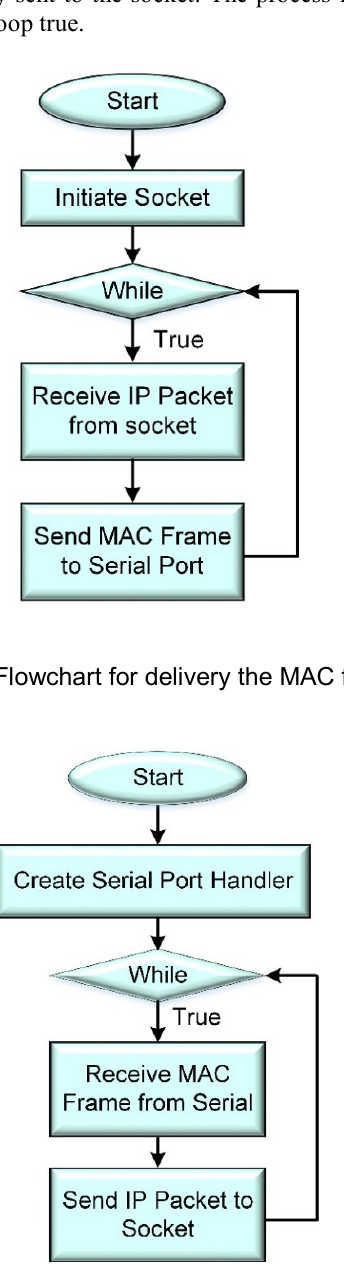
Figure 8. Flowchart for receiving the MAC frame